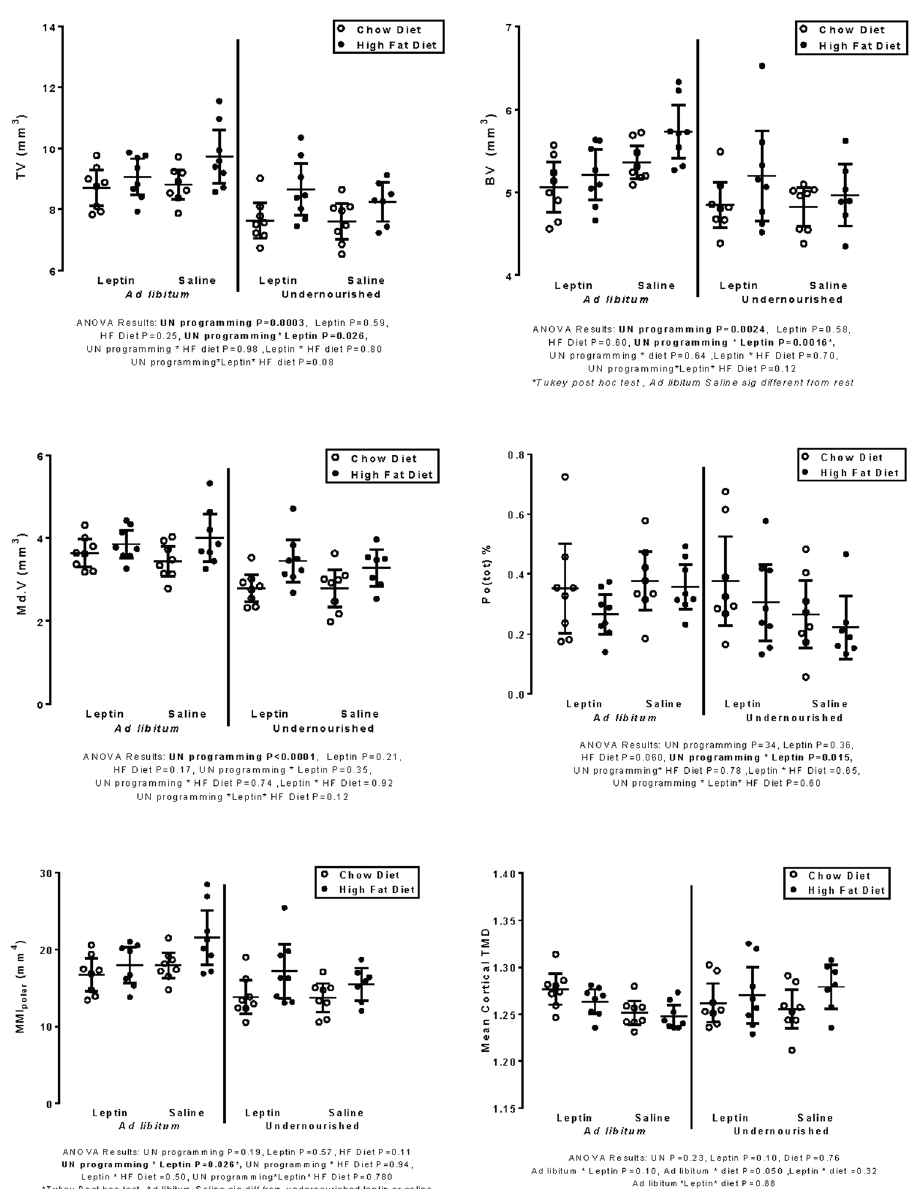
Figure 2. Cortical bone. Descriptive data (mean, 95% CIs) and ANCOVA results of direct and interaction effects of combinations of programming (UN = undernutrition vs AD = ad libitum feeding during pregnancy), Leptin vs Saline administration on neonatal days 3–13, and High Fat ( • ) vs Chow ( ◦ ) diet post-weaning on six bone morphometry measures. TV = total volume, BV = Bone volume, Md.V = Medullary volume, Po(tot) = % total porosity, MMI polar = polar moment of inertia, and TMD = mean cortical tissue mineral density. Statistically significant (P < 0.05) results are in